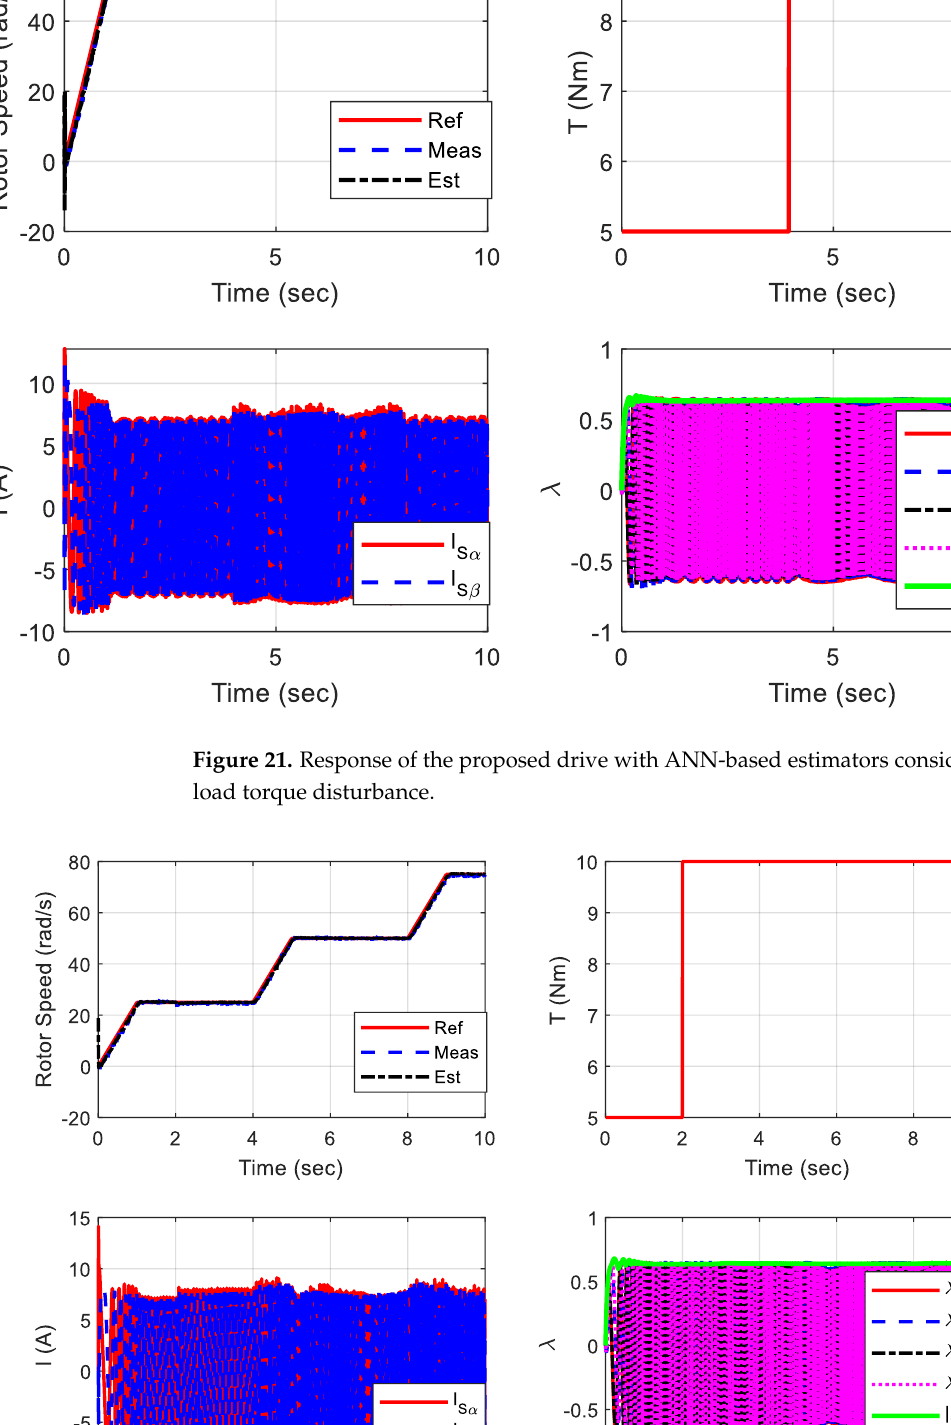
Figure 23. Actual and estimated 𝛼 − 𝛽 rotor flux components considering the case of rotor speed variation.